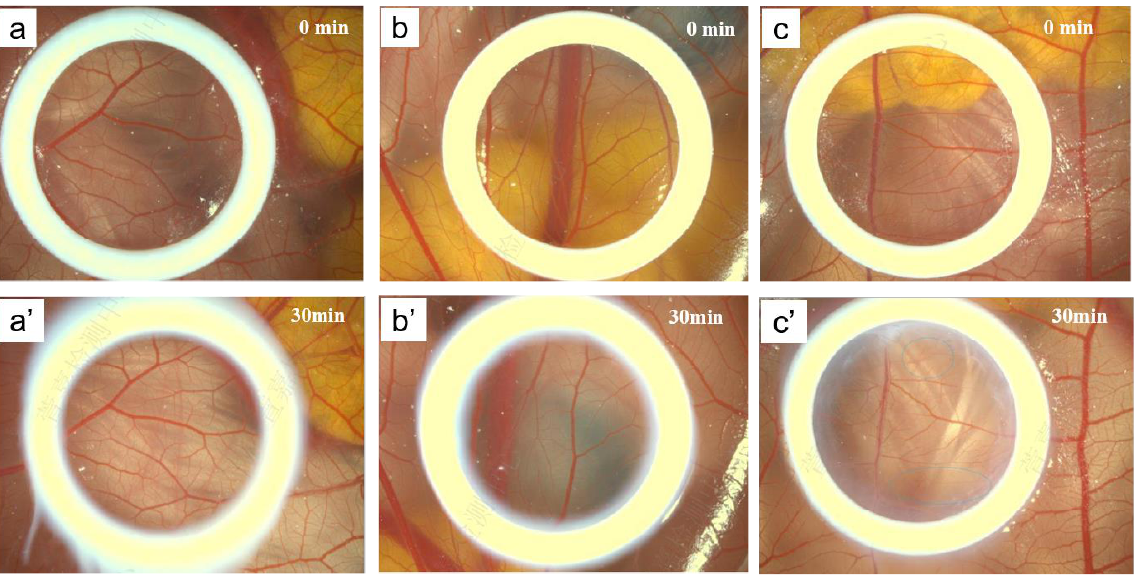
Figure 5. Effect of supramolecular Gravi-A nanoparticles on chorioallantoic membrane toxicity of chicken embryo after 30 min administration at different concentrations, where the yellow circle represents the selected viewing area. A total of 2.5% sample concentration in group ( a , a’ ), 4% sample concentration in group ( b , b’ ) , and 5% sample concentration in group ( c , c’ ).